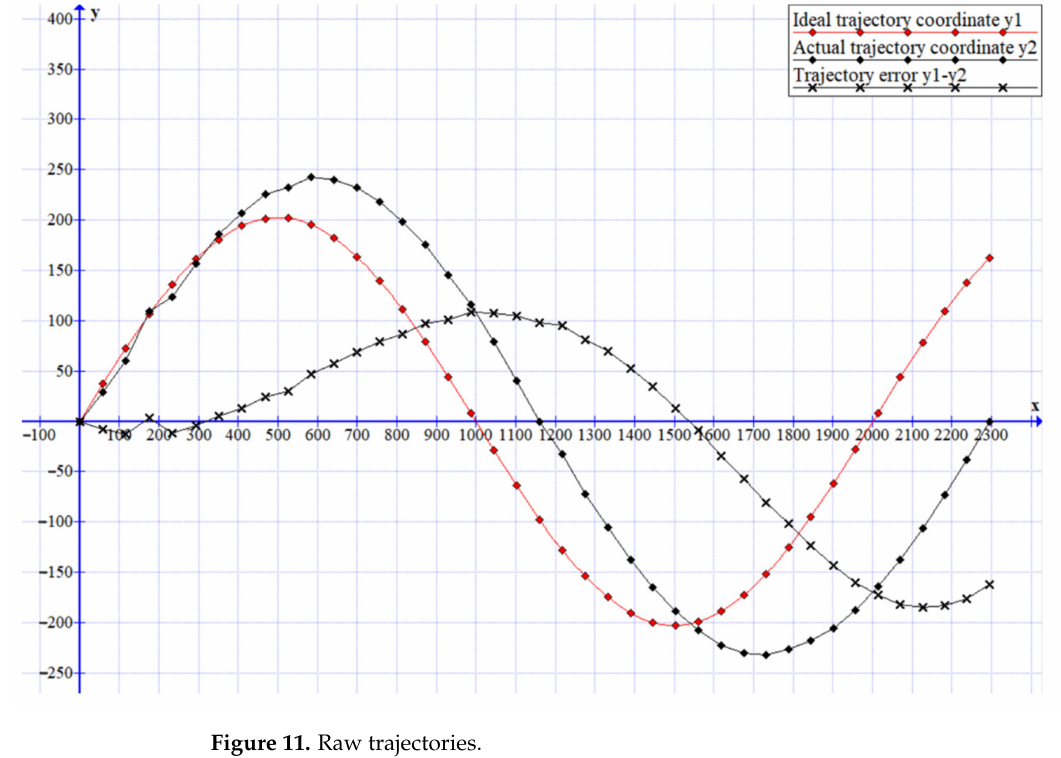
Figure 11. Raw trajectories.